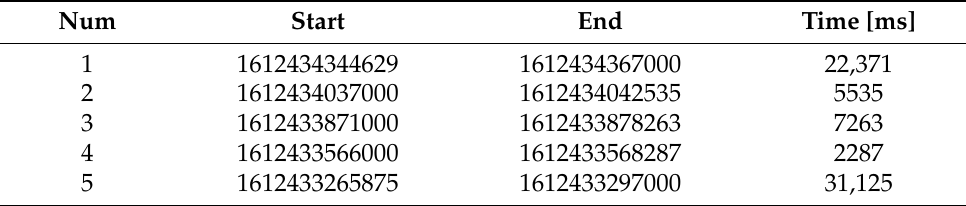
Table 4. The data collected during the